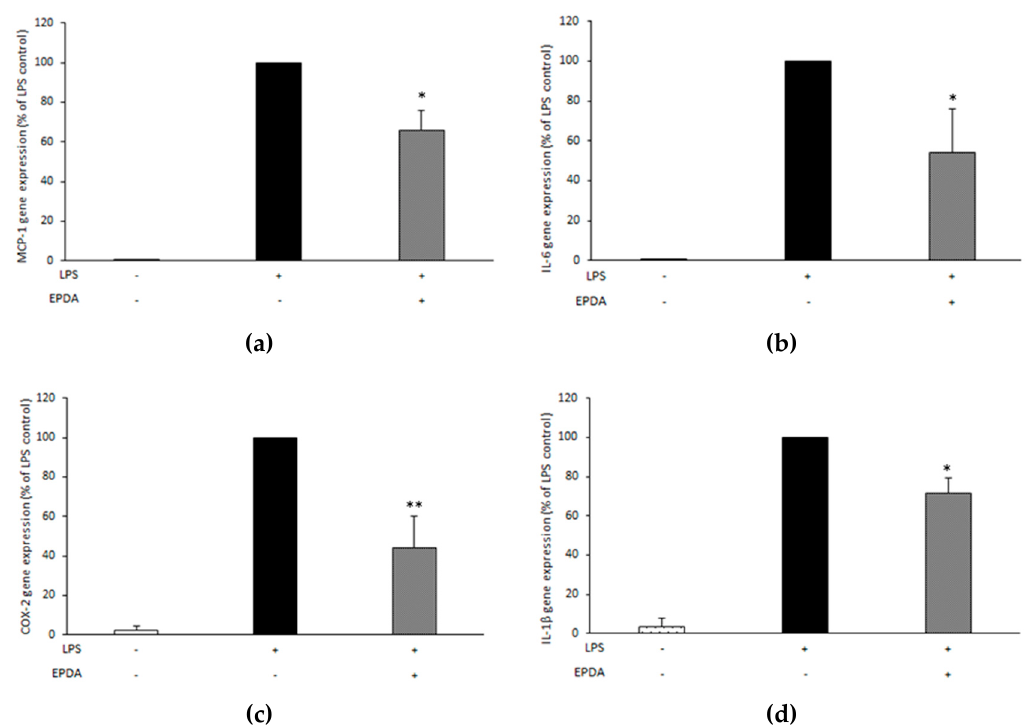
Figure 5. E ff ect of N -eicosapentaenoyl dopamine (EPDA) on the gene expression of MCP-1 ( a ), IL-6 ( b ), cyclooxygenase-2 (COX-2) ( c ), and interleukin-1 β (IL-1 β ) ( d ) by THP-1 macrophages exposed to lipopolysaccharide (LPS). Cells were seeded in 6-well plates at 1,000,000 cells / well in the presence of PMA (100 nM). After overnight incubation, and replacing of PMA-containing medium with fresh medium, attached cells were rested for 24 h and then stimulated with (or without) LPS (10 ng mL − 1 ) and with (or without) EPDA (1 µ M) for 4 h. Each sample was normalized on its 18S mRNA content. Data are expressed as percentages of LPS control (black bar, set at 100%), and represent the mean of three independent experiments (each done in triplicate) ± S.D. Asterisks indicate significantly di ff erent mean values from those of control (* p < 0.05, and ** p < 0.01).